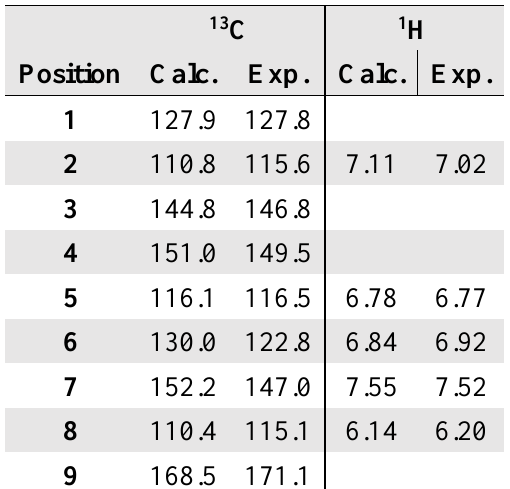
Table 2. Experimental (E UN et al. , 2010) and calculated chemical shifts (ppm) for 13 C- and 1 H-NMR spectra of caffeic acid in